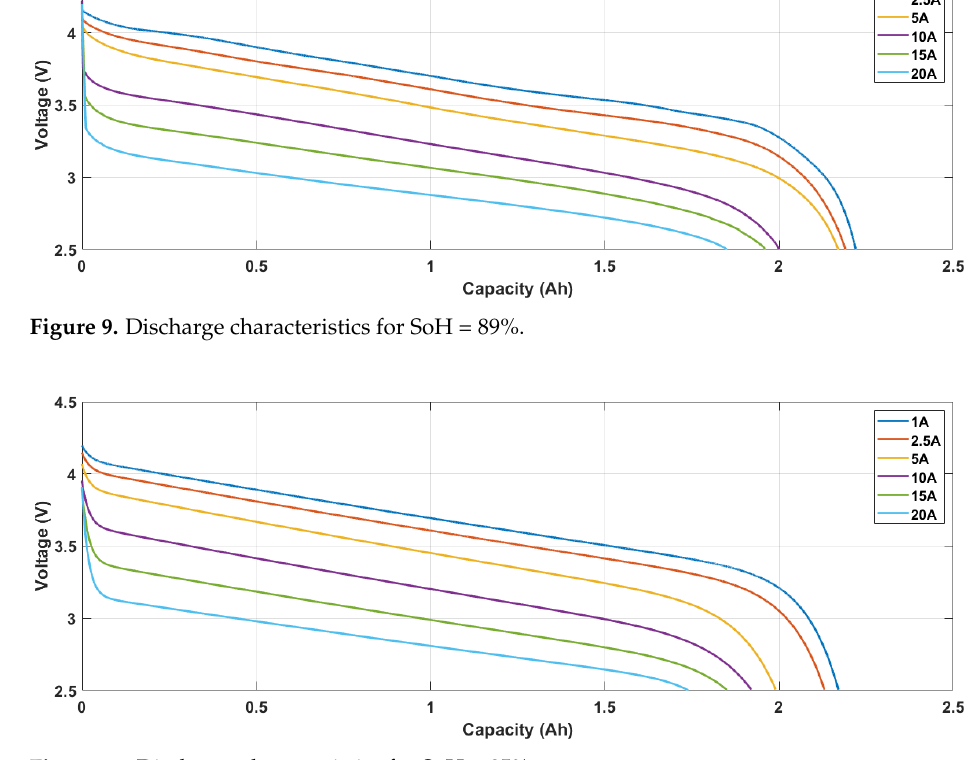
Figure 10. Discharge characteristics for SoH =